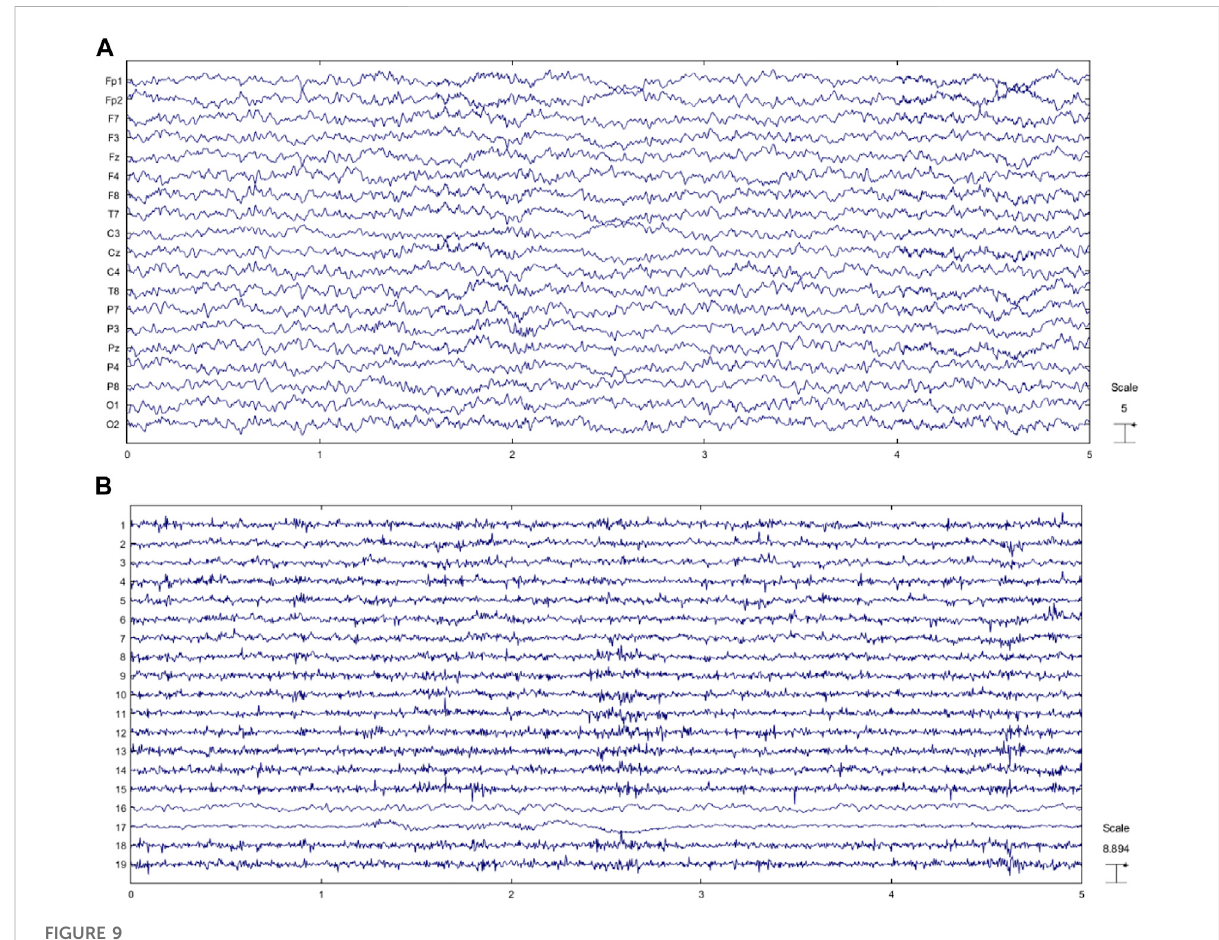
FIGURE 9 (A) Reconstructed EEG through the proposed method and (B) EEG